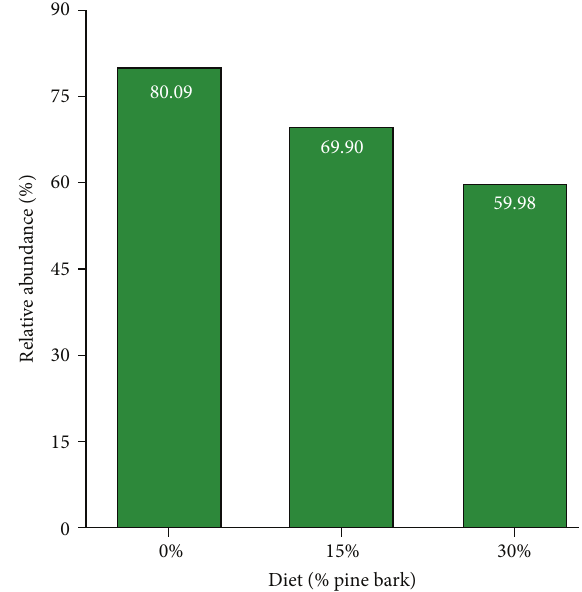
Figure 4: Relative abundance of major taxonomic group ( Eur- yarchaeota ) across pine bark (PB) dietary supplementation in grow- ing meat goats. Phyla included in this figure had relative abundance values consistently greater than 1%. Values presented are the mean percent. 0% = 0% PB (control), 15% = 15% PB, and 30% = 30% PB on an as-fed